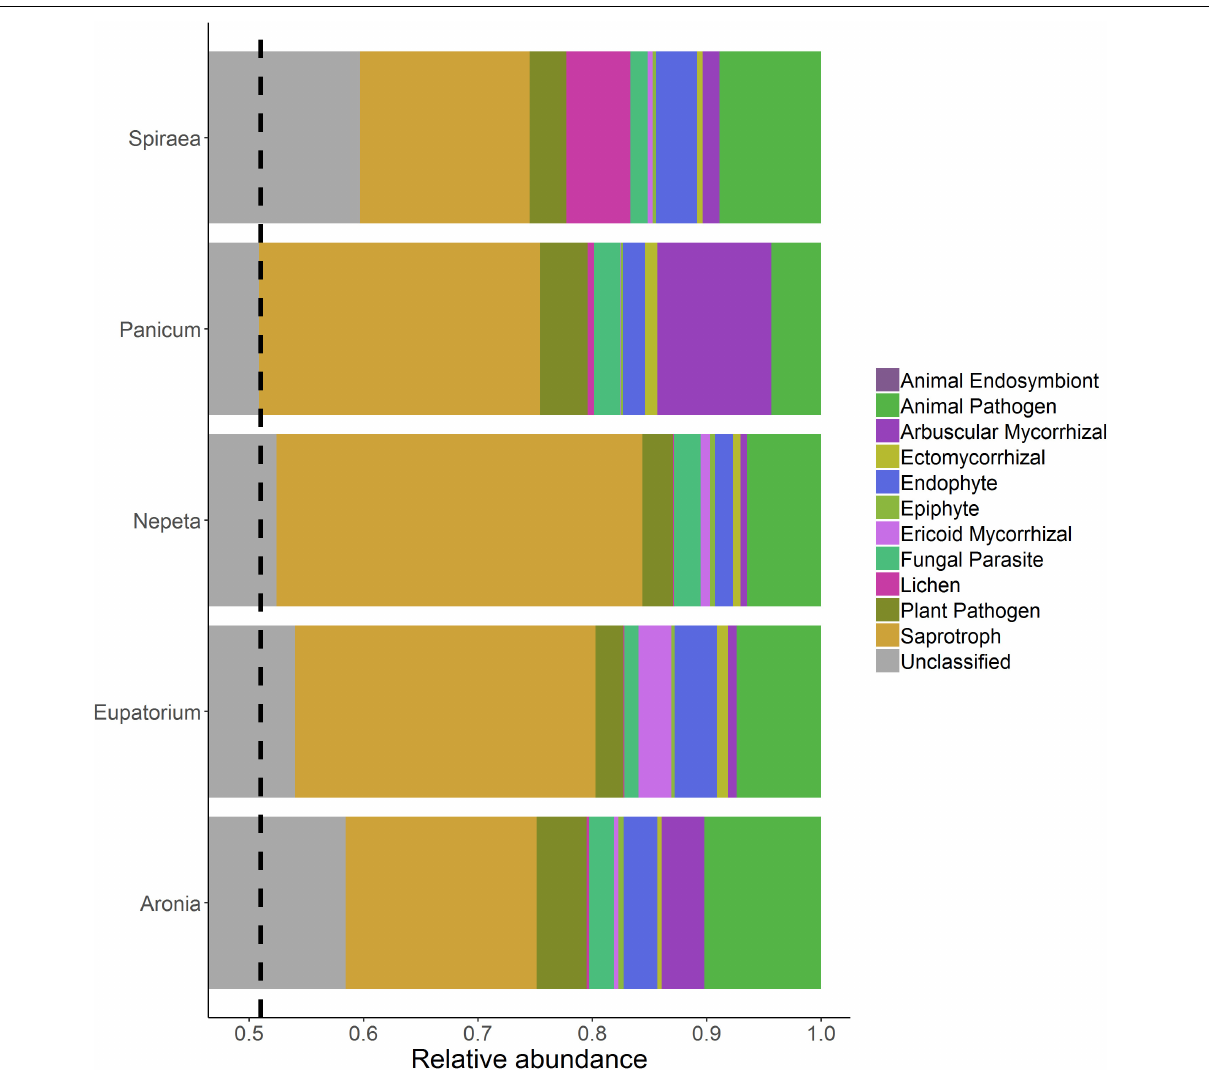
FIGURE 3 | Relative abundance of fungal functional groups from soils collected near the individual plant species listed on the left side of each bar. The dashed line references the start of the lowest unclassified grouping because the x -axis does not start at